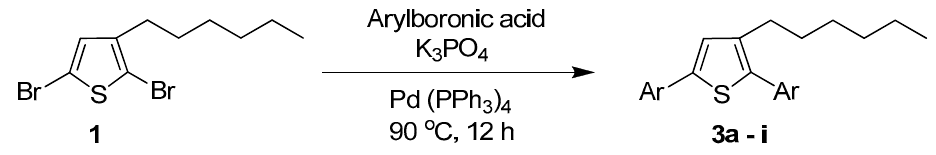
Scheme 1. Synthesis of 2,5-biaryl-3-hexylthiophene ( 3a – i ). 1 (1.0 mmol), Aryl-boronic acids (2.5 mmol),